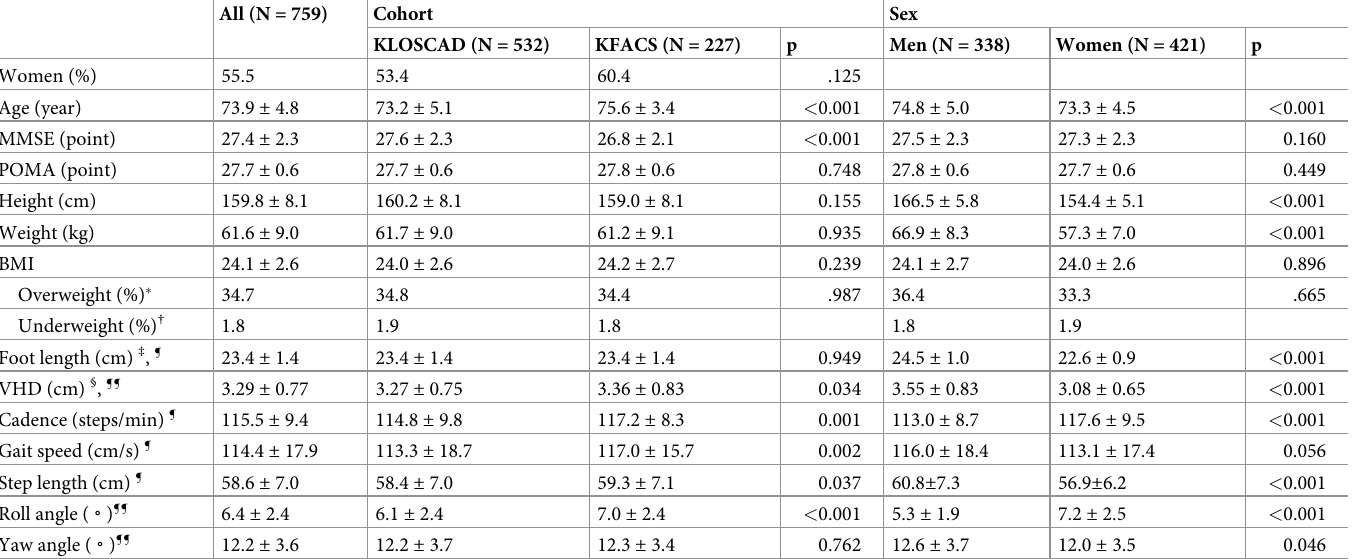
Table 1. Characteristics of the